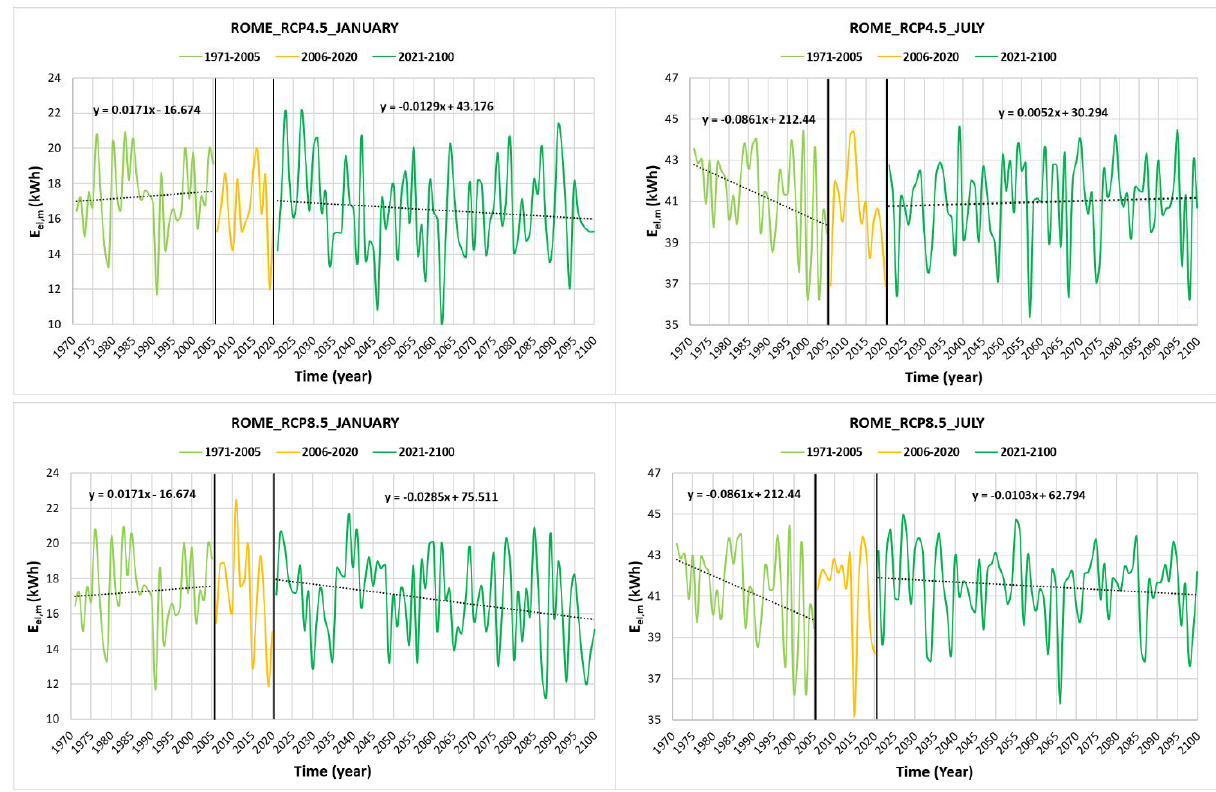
Figure 7. Rome ’ s monthly PV electricity variation in January ( left ) and July ( right ) from 1971 to 2100. ( Top ): RCP4.5, ( bottom ): RCP8.5.